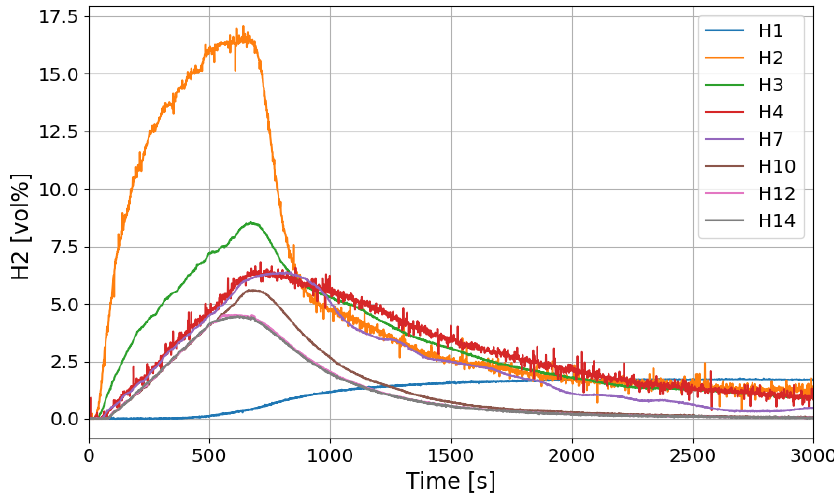
Figure 11. Hydrogen concentration distributions along a center line for the SP1 test.